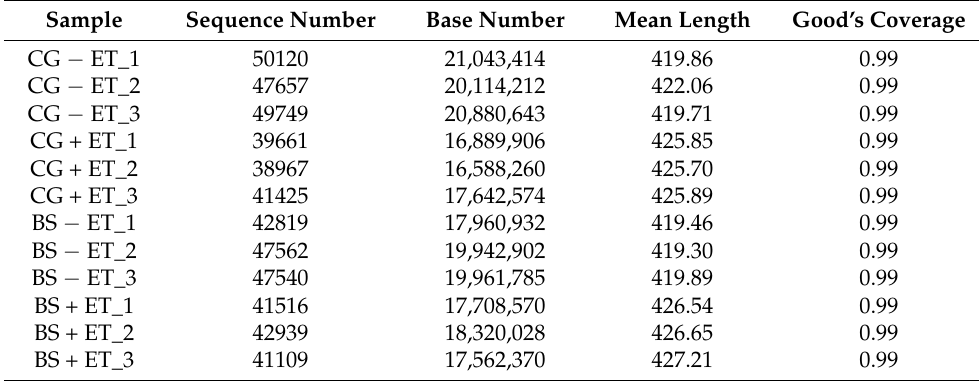
Table 1. Quality control